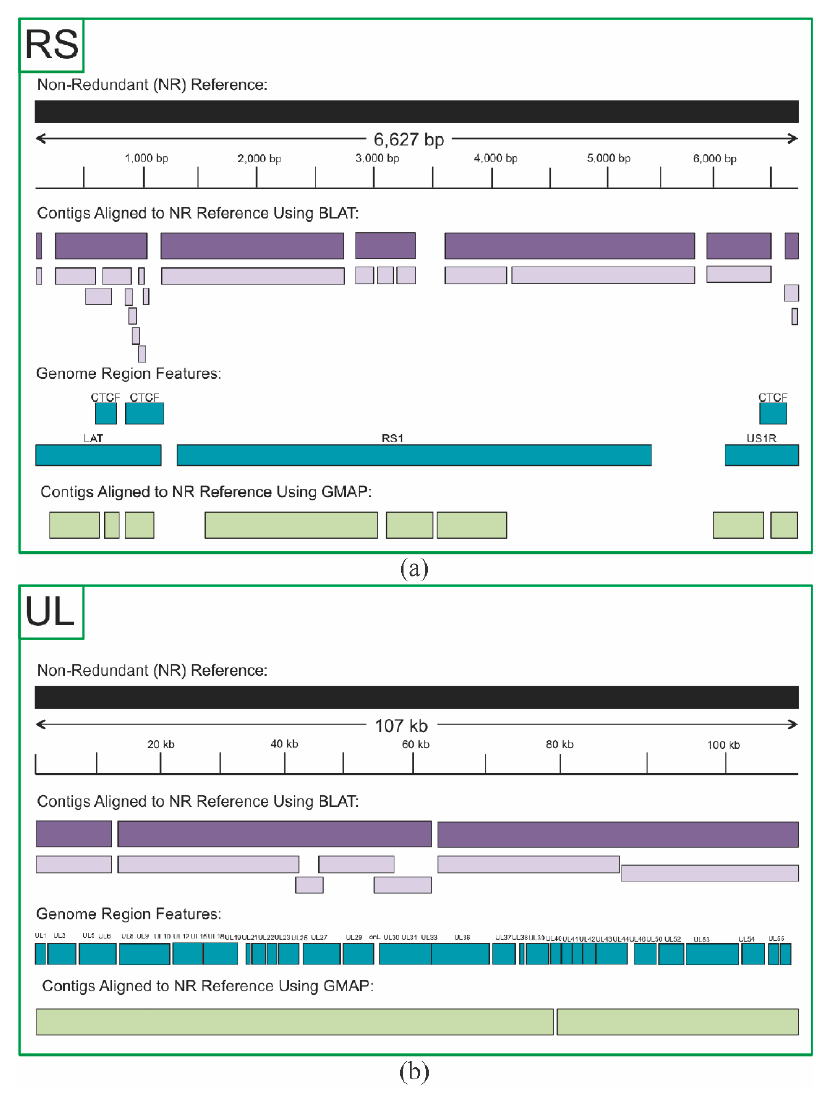
Figure 3. Contig alignment comparison using BLAST-like alignment tool (BLAT) and the Genomic Mapping and Alignment Program (GMAP) to the NR-reference. ( a ) Visualization of the alignment of 17syn+ contigs in the RS region of the NR-reference. Contigs aligned using BLAT are shown in light purple (consensus in dark purple) and contigs aligned using GMAP in green. Blue bars identify different genomics features; ( b ) Visualization of the alignment of 17syn+ contigs in the UL region of the NR-reference. Colors as in ( a ).